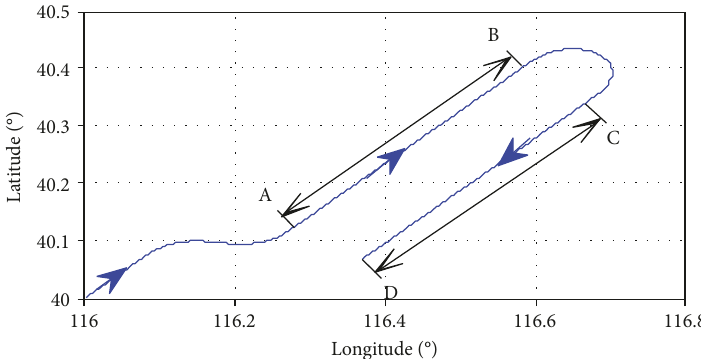
Figure 4: Plane trajectory with S-shaped maneuver plus U-shaped fl ight.